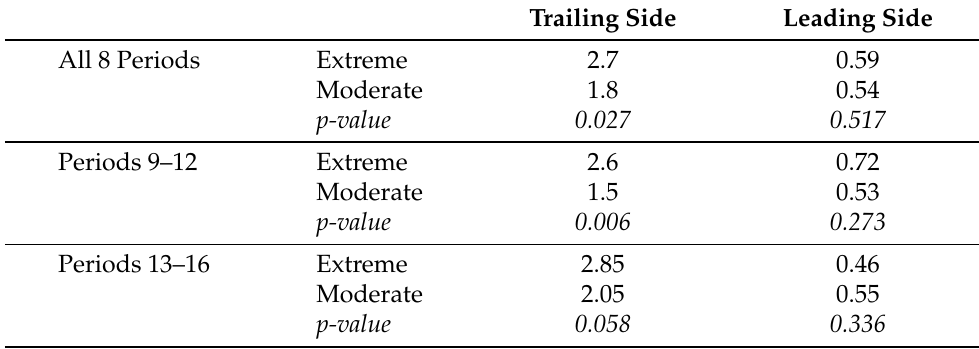
Table 5. Centrist’s votes from the leading and trailing